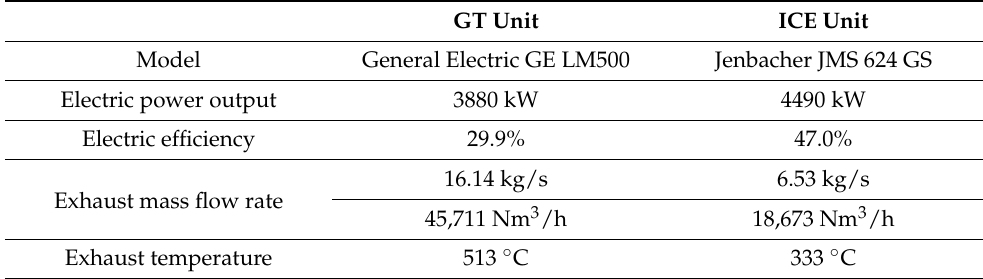
Table 6. Main characteristics for selected CHP PM units [40].